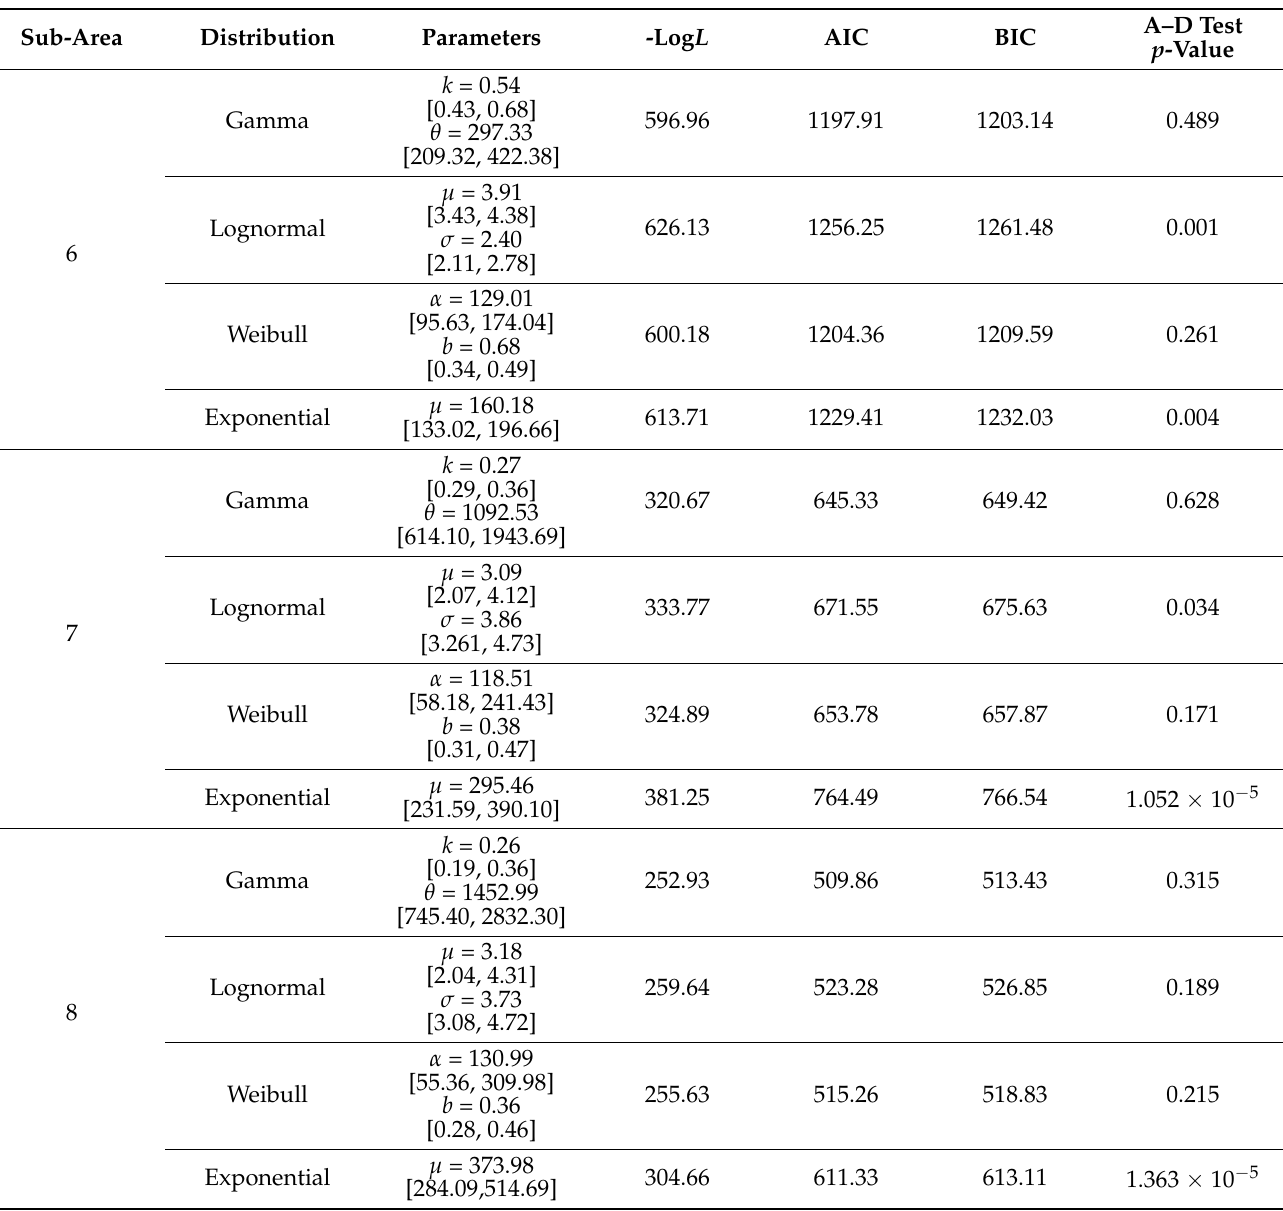
Table 4. MLE parameters estimates, 95% confidence intervals, log-likelihood values calculation, Akaike and Bayesian Information Criteria calculated values (AIC and BIC, respectively), along with the estimated p -values of the Anderson–Darling Goodness of Fit test for the four applied statistical distributions on the statistically independent interevent times data, ∆ T , of the sub-areas 6 to